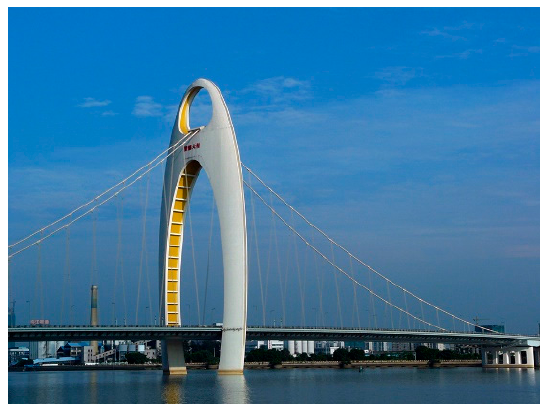
Figure 20. Liede Bridge (photo: Zoom4902, Wikimedia Commons).